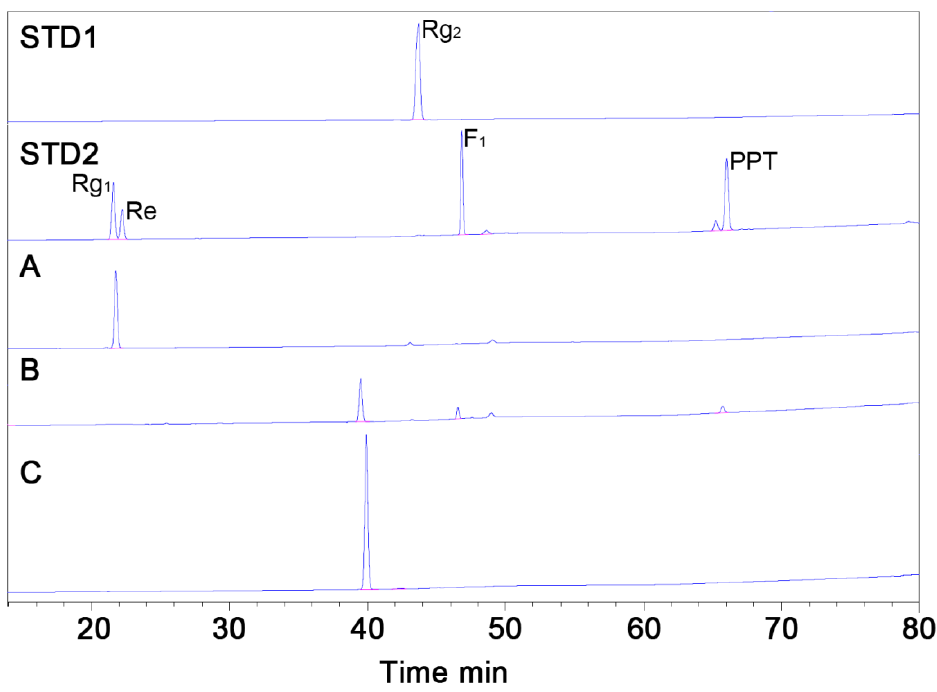
Figure 4. HPLC analysis of purified MT1 from the product mixture. (STD1), ginsenoside Rg 2 (S) standard; (STD2), standards of ginsenosides Rg 1 , Re, F 1 and PPT; ( A ), substrate ginsenoside Re before purification; ( B ), biotransformed products from the MT619 conversion mixture; ( C ), MT1 isolated using Recycling preparative high-performance liquid chromatography (RPHPLC).